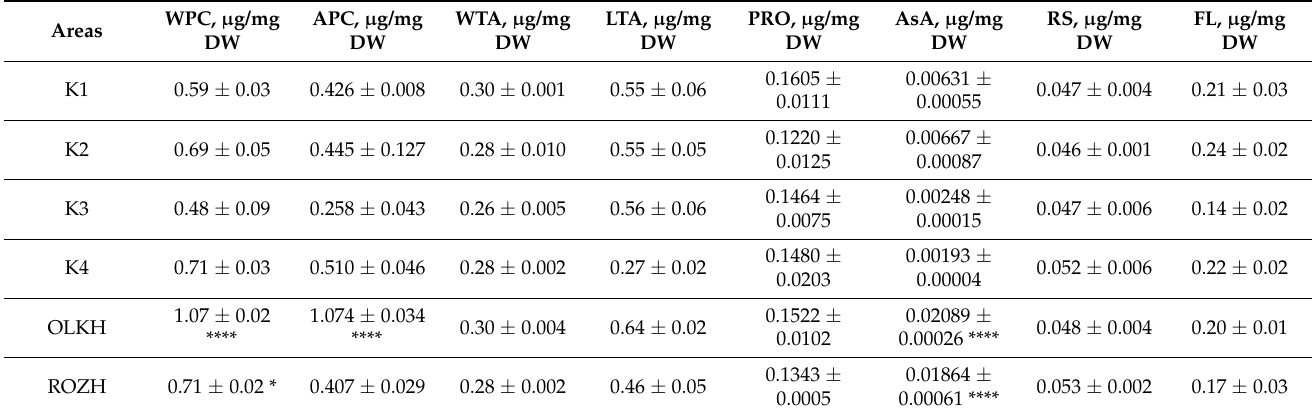
Table 5. The concentration of low molecular weight antioxidants in H. tuberosus plants growing in pollution-free zones and in areas with 137 Cs contamination. **** corresponds to p < 0.00001 significance level; * corresponds to p < 0.05 significance